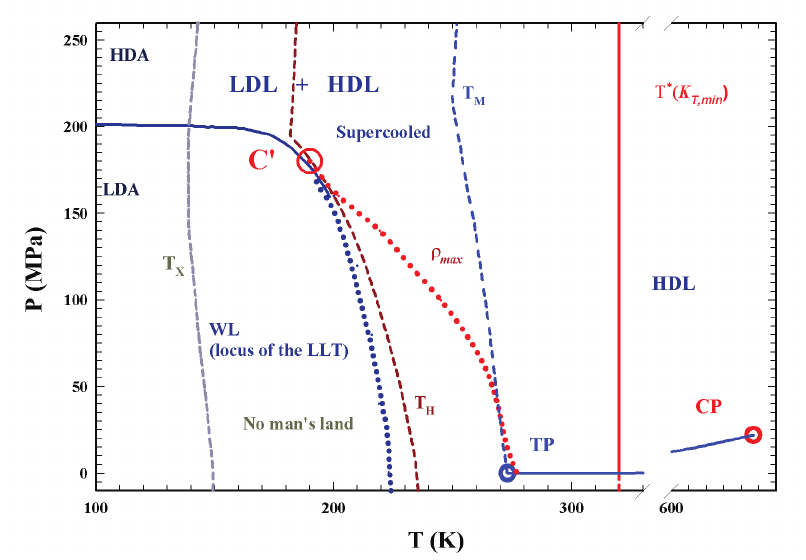
Figure 1. The P − T water phase diagram. All the lines characterizing the chemical physics of the system in the liquid and disordered phases (glasses) are illustrated together with the homogeneous nucleation temperature ( T h ) and that of crystallization of the ultra-viscous liquid ( T x ) defining the “no man’s land”. The Widom line (characteristic of liquid–liquid transition) is also proposed together with those of the maximum density ( ρ max ) and the melting temperature ( T m ), the critical point C P and the estimated (by MD) LLCP ( C (cid:48) ) [2]. T ∗ is the temperature of the minimum of the isothermal compressibility κ T [28]. Finally , the regions of the polymorphism (LDL + HDL) and those for T > T * composed only of HDL are